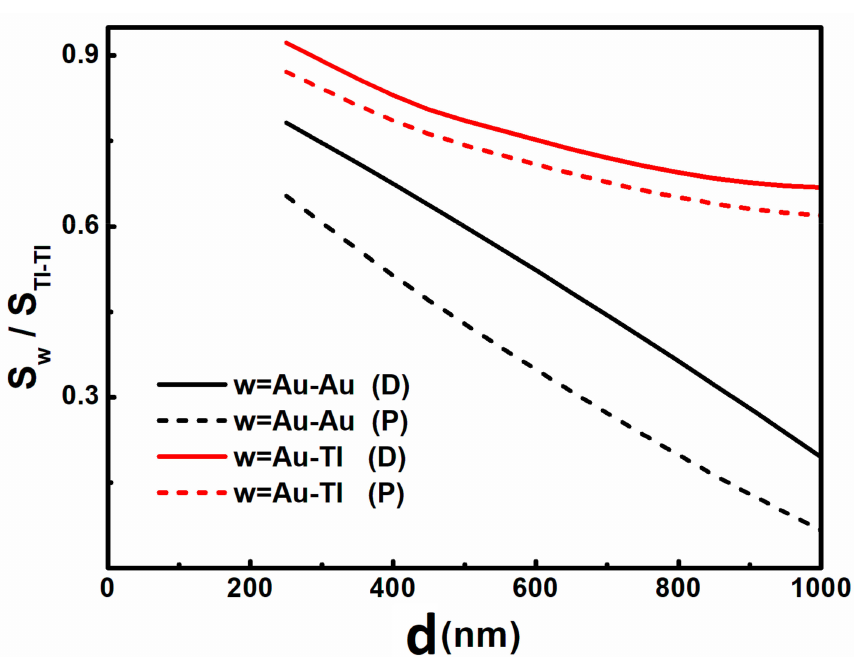
Figure 4. Ratio of the stable area of actuation between different systems (Au-Au and Au-TI) and the TI-TI system vs. initial separation distance for the extrapolations at low frequencies for Au via the Drude ( D ) and Plasma ( P ) models. For the calculations, we considered δ Cas =